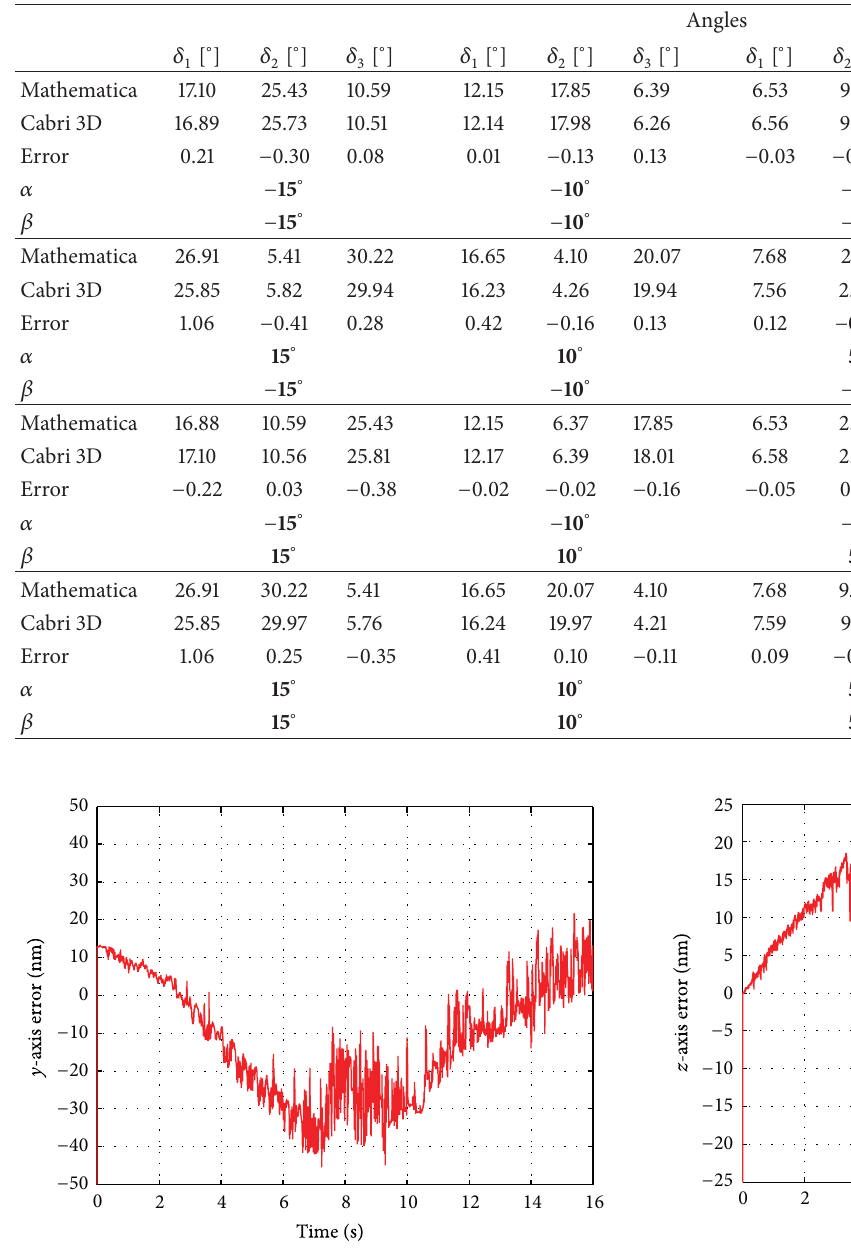
Figure 13: Error generated by computational model in 𝑌 -axis. Figure 14: Error generated by computational model in 𝑍